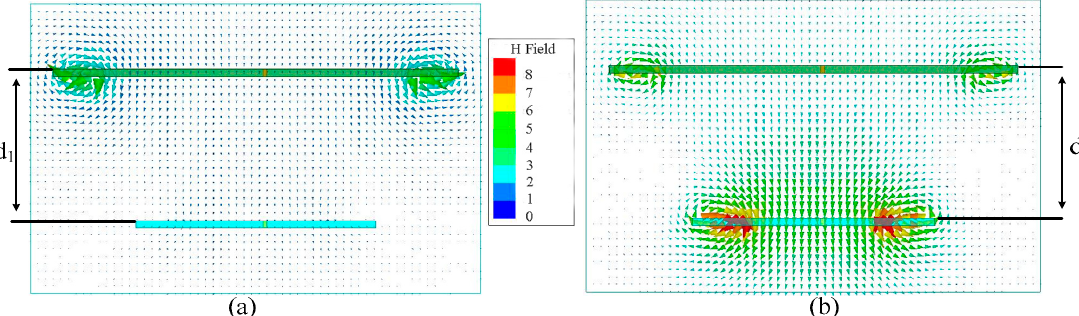
Figure 14. Reflection coefficients of all above-discussed CAs. ( a ) the top coil antenna is a conventionally matched coil antenna operating; ( b ) only the bottom one is replaced by an optimized miniaturized CA.